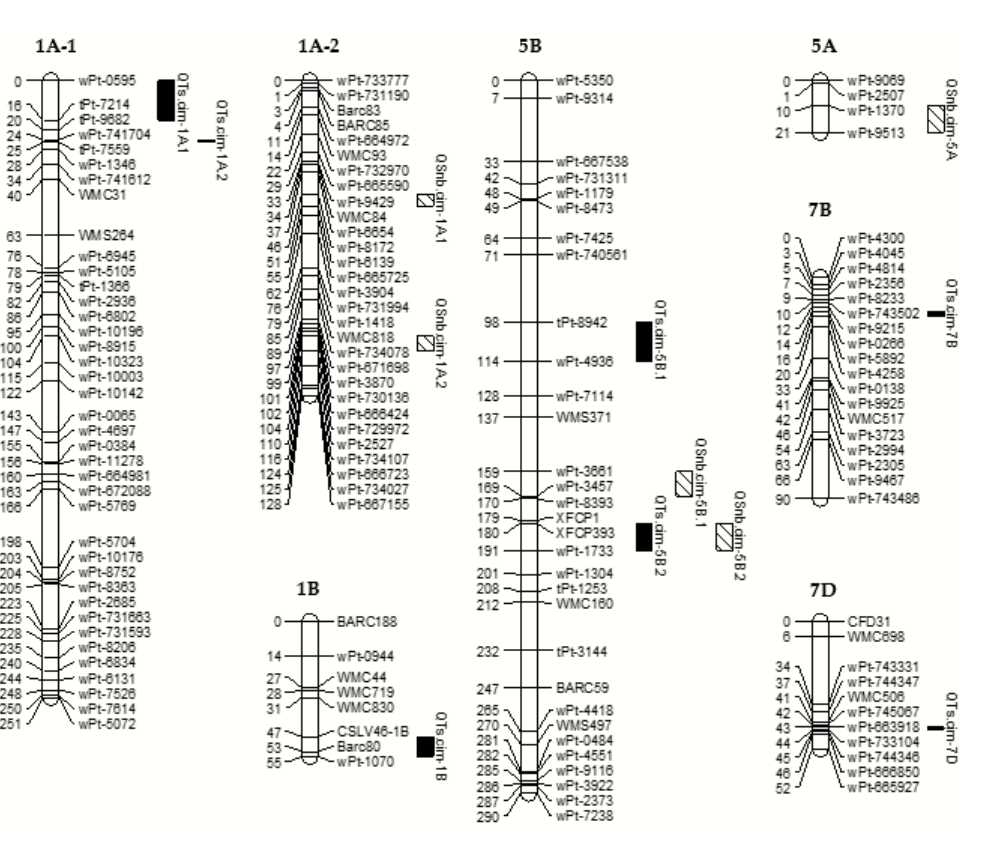
Figure 2. Linkage groups with significant QTLs for seedling resistance to tan spot and Septoria nodorum blotch in the PBW343 / KN population. Refer to Tables 3 and 4 for the naming of the linkage groups.